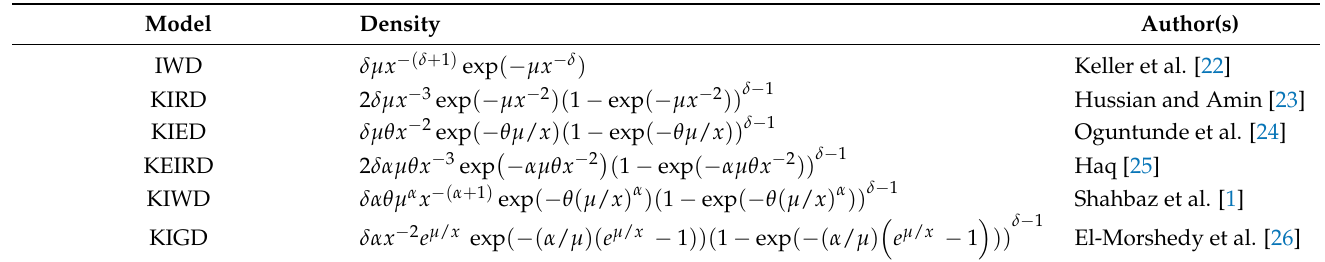
Table 2. Several competing models of Type-II Lehmann–Fréchet distribution.